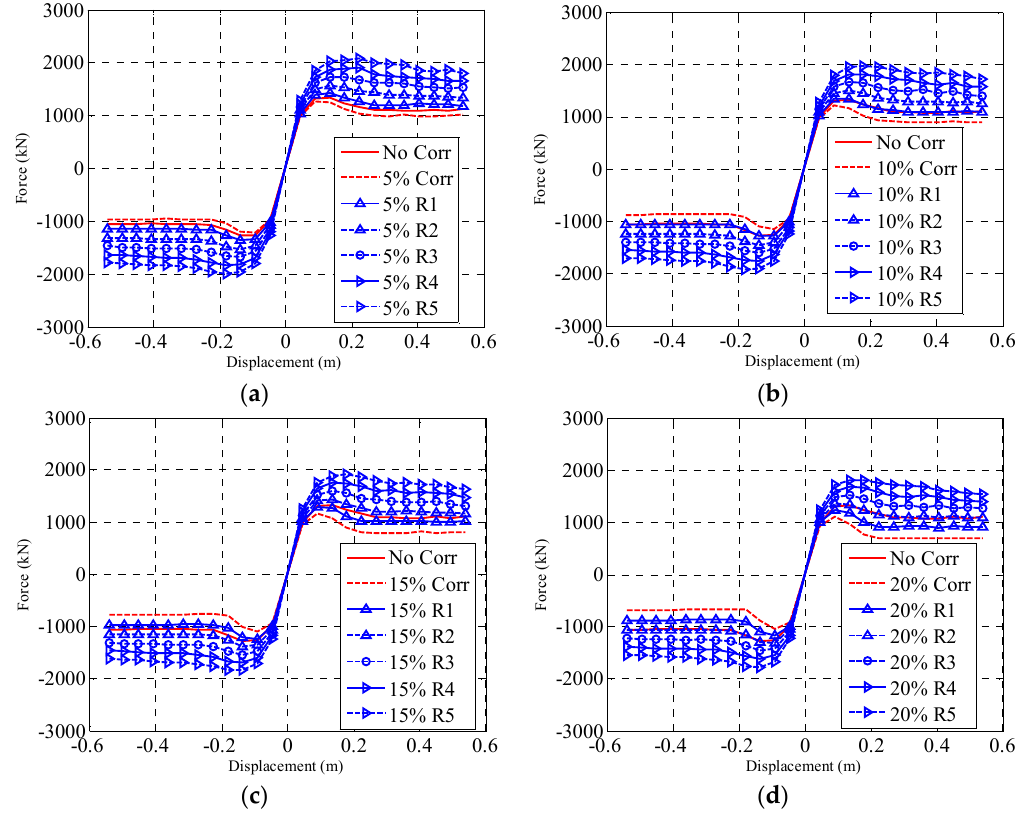
Figure 4. Skeleton curves for a bridge pier with pitting corrosion. ( a ) 5%, ( b ) 10%, ( c ) 15%, ( d ) 20%. Based on the skeleton curves, the peak forces were extracted and are listed in Tables 2–5. For example, Table 2 lists the peak force for a bridge pier with 5% corro- sion, reinforced by steel plates of different thicknesses. The peak force is 1321.8 kN for no corrosion, and that of the bridge with 5% corrosion is 1257.7 kN; the peak force reduces by approximately 4.85%. Tables 2–5 list the peak force ratios for the bridge pier before and after the reinforcement. A negative value in the table indicates that the peak force is smaller than its original state, while a positive value implies that the capacity of the reinforced bridge pier is greater. From Tables 2–5, it can be concluded that uniform corrosion has a smaller effect on the capacity of the bridge pier compared to that of the bridge pier with pitting corrosion. For example, the peak force of the bridge pier without reinforcement is about 1257.7 kN for pitting corrosion with a corrosion level of 5%, and the peak force of the bridge pier is about 1275.9 kN for uniform corrosion with the same corrosion ratio without reinforcement, which is about 1.5% greater than that of the pitting corrosion. From